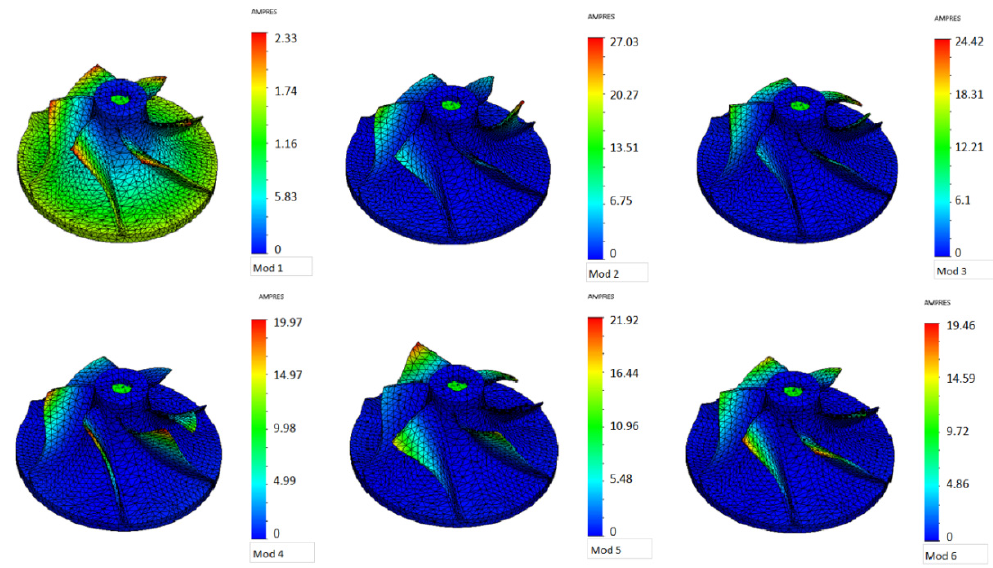
Figure 6. Amplitude values representation for modes 1 to 6.